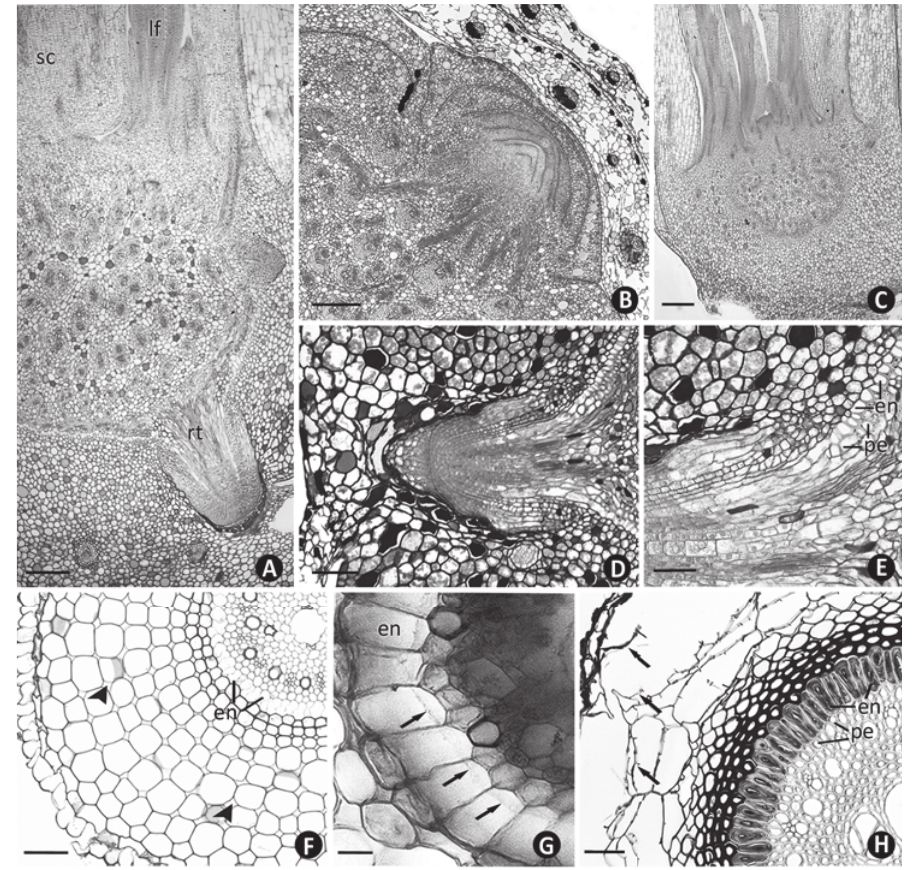
Fig. 2 - Anatomical aspects of transverse and longitudinal sections of rhizome and roots of Cyperaceae species: Cyperus laxus L. and Fimbristylis dichotoma Vahl. A. Fimbristylis dichotoma , longitudinal section of the mature rhizome showing root, leaf primordia and scape in protrusion; B. Cyperus laxus , transverse section of the mature rhizome; C-E. Fimbristylis dichotoma , mature rhizome; C. Longitudinal section showing leaf primordia; D. Transverse section showing roots protrusion; E. Detail of roots protrusion; F. Cyperus laxus , general view of the young root showing the separation of the cell walls (arrows); G-H. Fimbristylis dichotoma , roots; G. Detail of the root showing Casparian strips in the endodermal cells (arrows); H. General view of the mature root showing lyse of the cell walls (arrows) and endodermis and pericycle with thick-walled cells. en = endodermis; lf = leaf; pe = pericycle; rt = root; sc = scape. Bars = 200 µm ( A, B ); 100 µm ( C, D ); 50 µm ( E, F, H ); 20 µm ( G